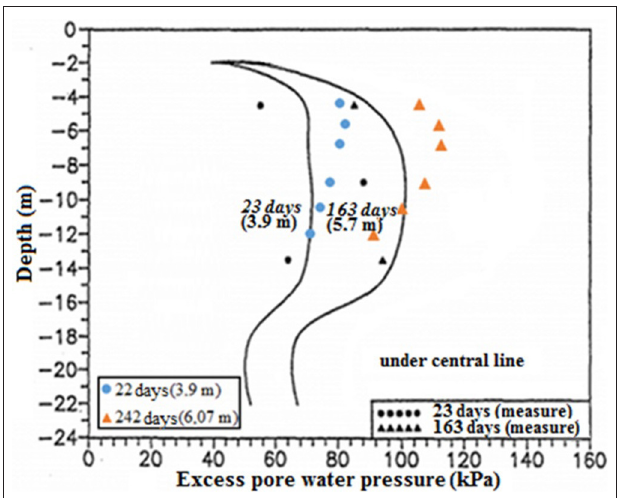
FIGURE 2 | Comparison between results of excess pore water pressure (adapted from Chai and Bergado, 1993, with permission from Bergado).